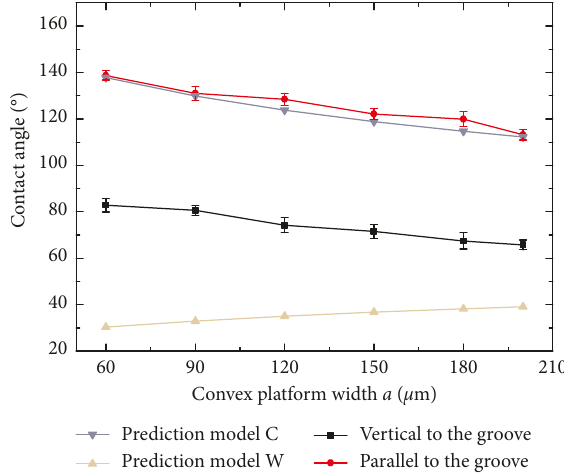
Figure 8: Variation curve of contact angle between measurement and